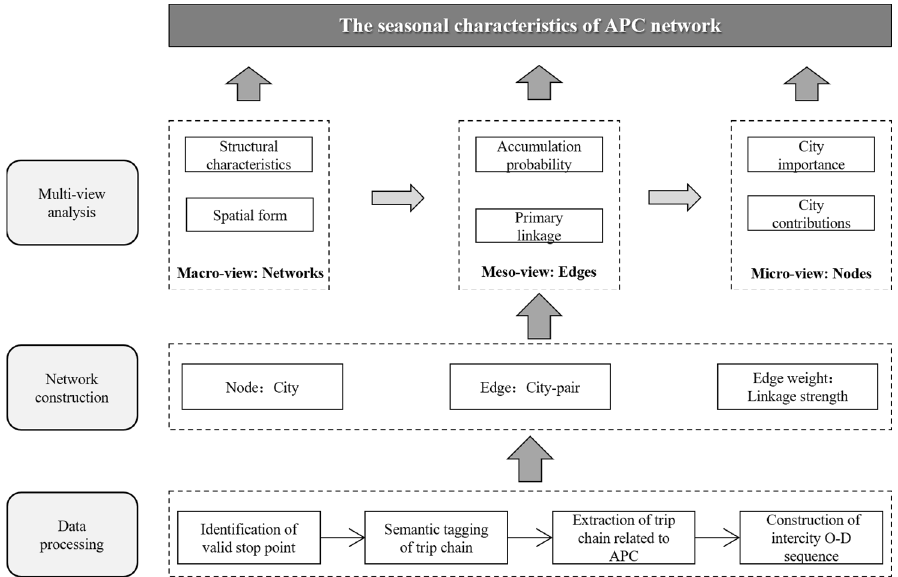
Figure 2. Analysis framework of agricultural product circulation networks.